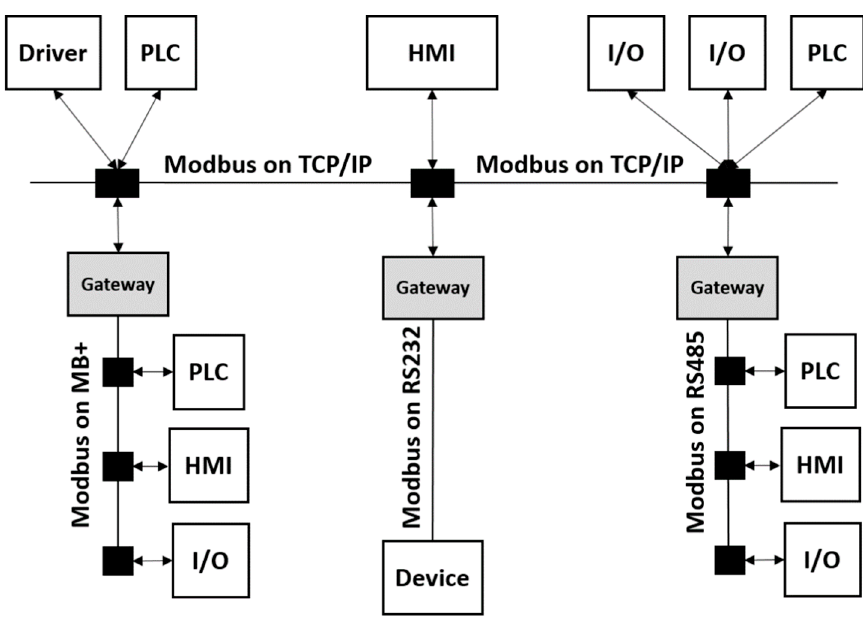
Figure 2. Example of Modbus Network Architecture [2].